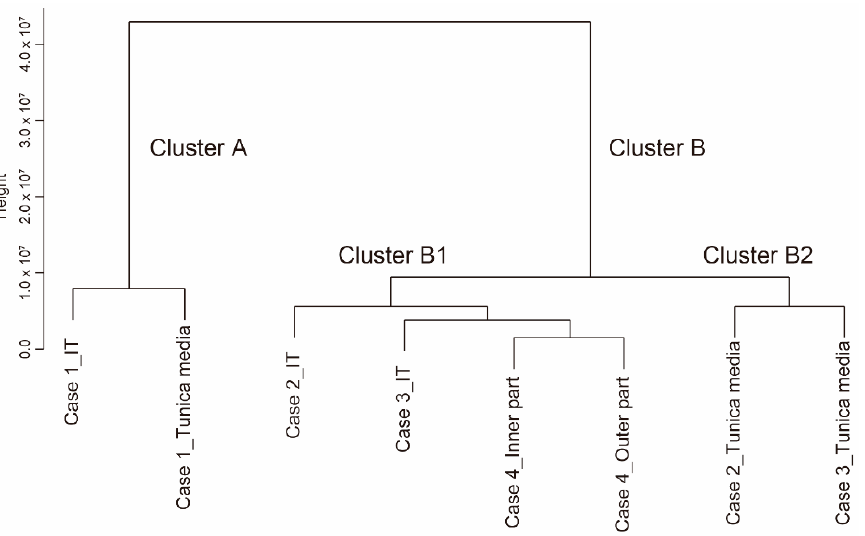
Figure 2. A dendrogram of the gene expressions from human ductus arteriosus tissues. IT: intimal thickening.